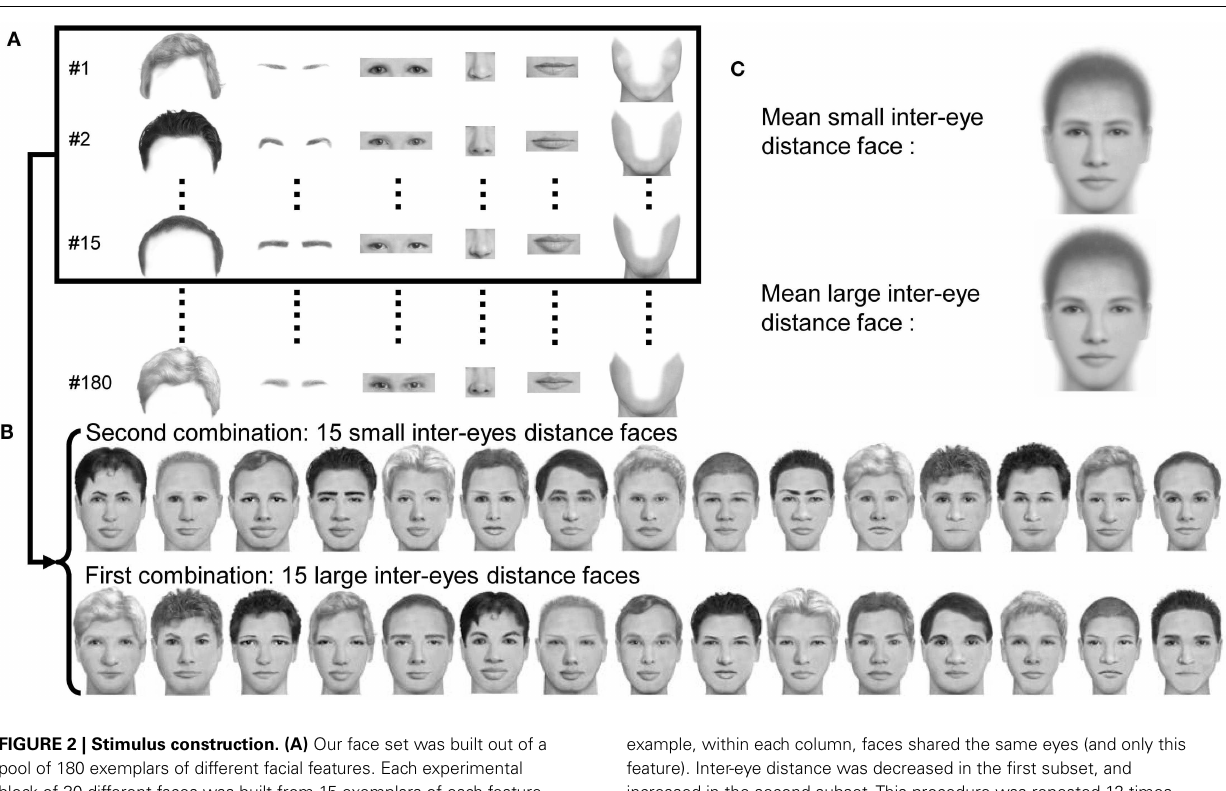
example, within each column, faces shared the same eyes (and only this feature). Inter-eye distance was decreased in the first subset, and increased in the second subset.This procedure was repeated 12 times so that all the 180 features were used once. (C) Mean faces in the two conditions of inter-eye distance, showing that only this feature varied across the two